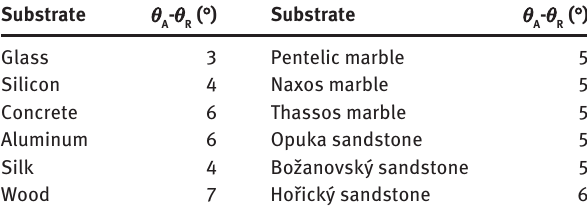
Table 2 Contact angle hysteresis ( θ faces, which were covered by siloxane-nanoparticle films, according to the method shown in Figure 11 .